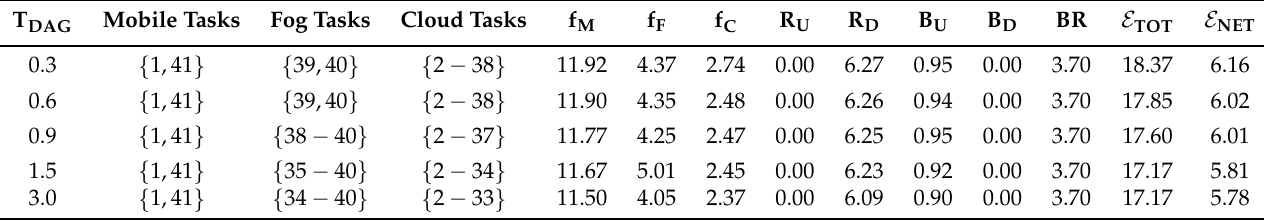
Table 8. Task, resource allocation, and energy consumption returned by GeneticTA_par under DAG3. Resources are measured in Mbit/s and energies in Joule. T